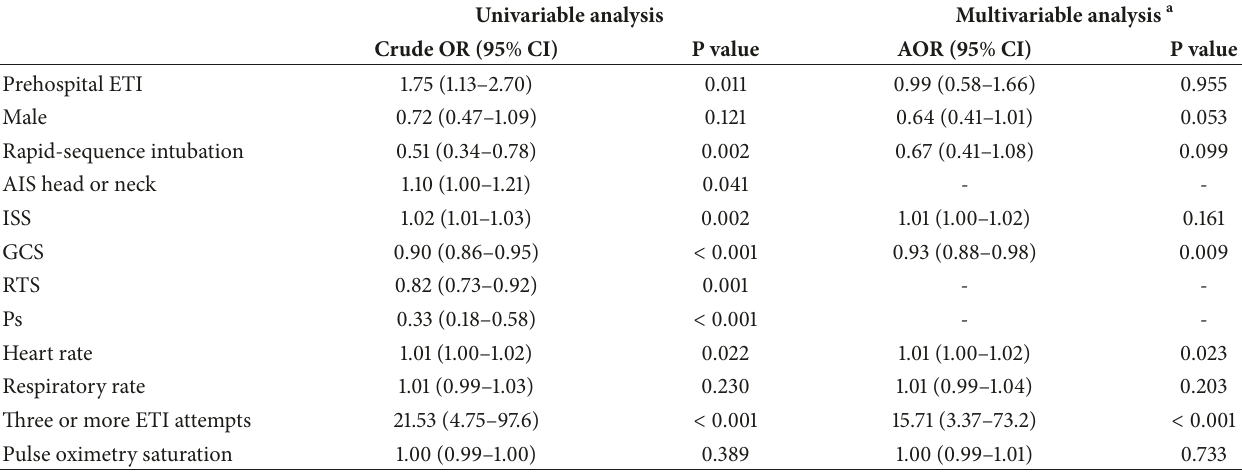
Table 3: Logistic regression models for occurrence of airway-related complications in injured patients.